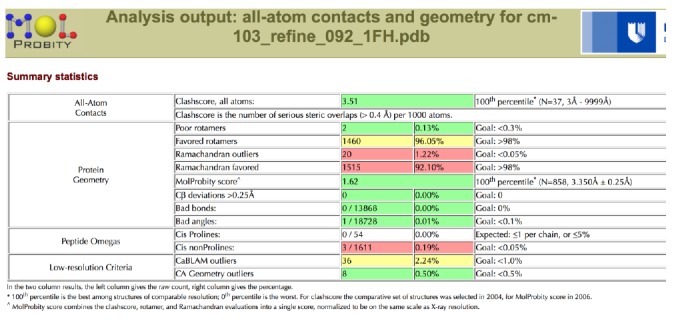
DOI:
http://dx.doi.org/10.7554/eLife.22567.023